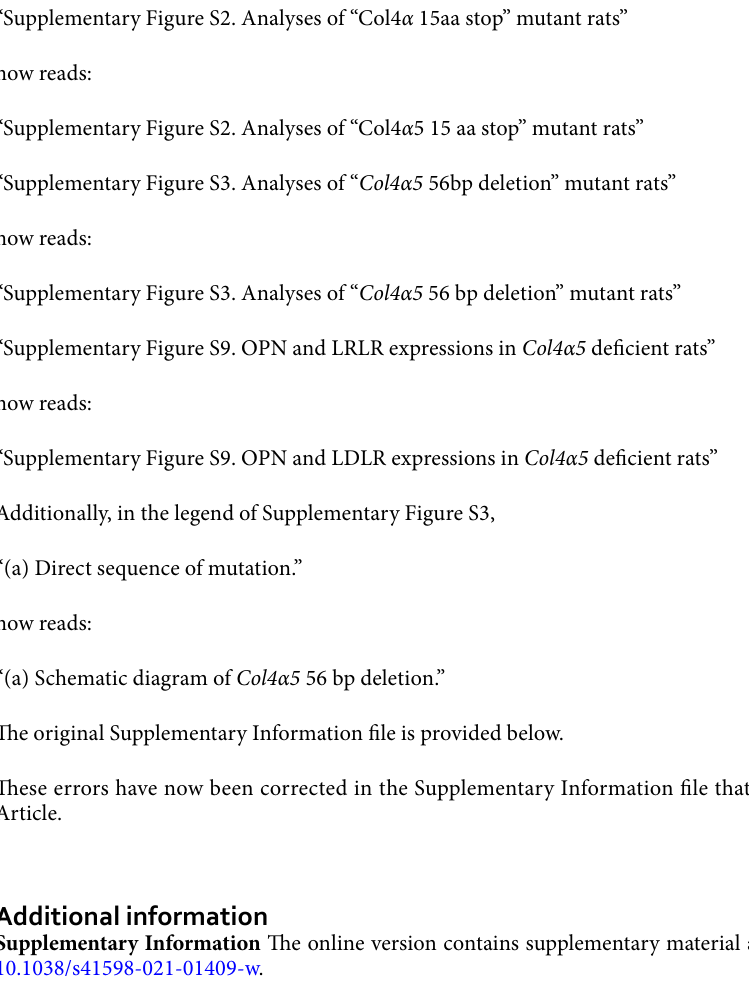
“Supplementary Figure S3. Analyses of “ Col4α5 56 bp deletion” mutant rats” “Supplementary Figure S9. OPN and LRLR expressions in Col4α5 deficient rats”